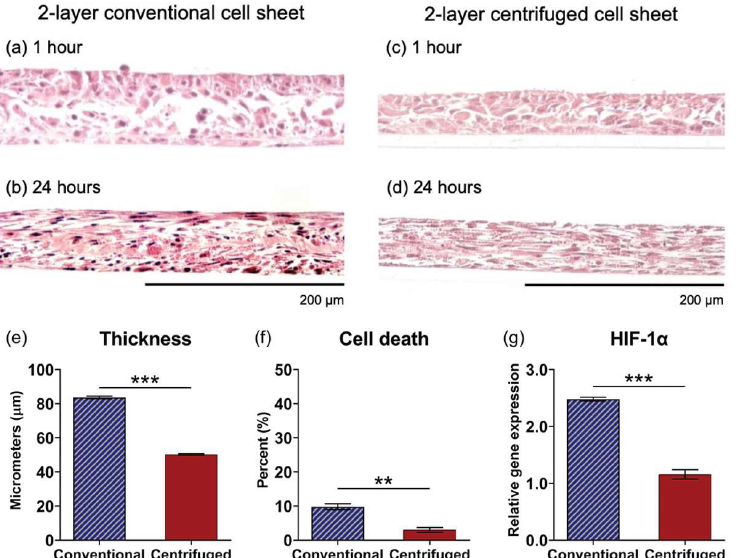
To investigate two-layer sheet cellular function, gene expression levels related to cell– cell interaction, cell–ECM interaction, and regenerative cytokine production were meas- ured. MSC gene expression for β-catenin was significantly upregulated in two-layer con- ventional cell sheets ( p = 0.018) (Figure 6a). Sheets fabricated by centrifugation layering demonstrated significantly increased MSC gene expression for a gap junction protein, connexin 43 ( p = 0.0067), as well as for cell–ECM interaction-related proteins, integrin β1 Figure 5. Centrifugation layering enables viable 2-layer cell sheet tissue fabrication. Histologi- ( p = 0.0048) and laminin α5 ( p = 0.0003) (Figure 6b–d, respectively), relative to MSCs in two-layer conventional cell sheets. VEGF, HGF, and IL-10 gene expression per MSC are cal assessment of 2-layer conventional and centrifuged cell sheets 1 h ( a , c , respectively) and 24 h significantly upregulated in two-layer centrifuged cell sheets 24 h after fabrication ( p = ( b , d , respectively) after layering, visualized as cross-sections stained with H&E. Additionally, 2-layer 0.037, p = 0.015, and p = 0.021, respectively) (Figure 6e–g, respectively). Additionally, se- cell sheets fabricated by conventional or centrifuge methods were compared for ( e ) tissue thickness in creted VEGF, HGF, and IL-10 concentrations in culture supernatants were 1.3-fold, 1.8- fold, and 2.0-fold increased per cell ( p = 0.011, p = 0.0001, and p = 0.0003, respectively) from 1-h samples, and for ( f ) cell viability and ( g ) HIF-1 α gene expression in 24 h samples. Gene expression two-layer centrifuged sheets relative to conventional sheets (Figure 6h–j). Live cell num- is normalized to GAPDH and compared to the 1-layer conventional cell sheet. Scale bars = 200 µ m. bers were similar in two-layer conventional (126 × 10 4 ± 7.0 × 10 4 cells) and centrifuged Values are means ± SE (** p < 0.01 and *** p < 0.001). NS = not significant ( p > 0.05). sheets (123 ± 5.1 × 10 4 cells) at 1 day in static culture.